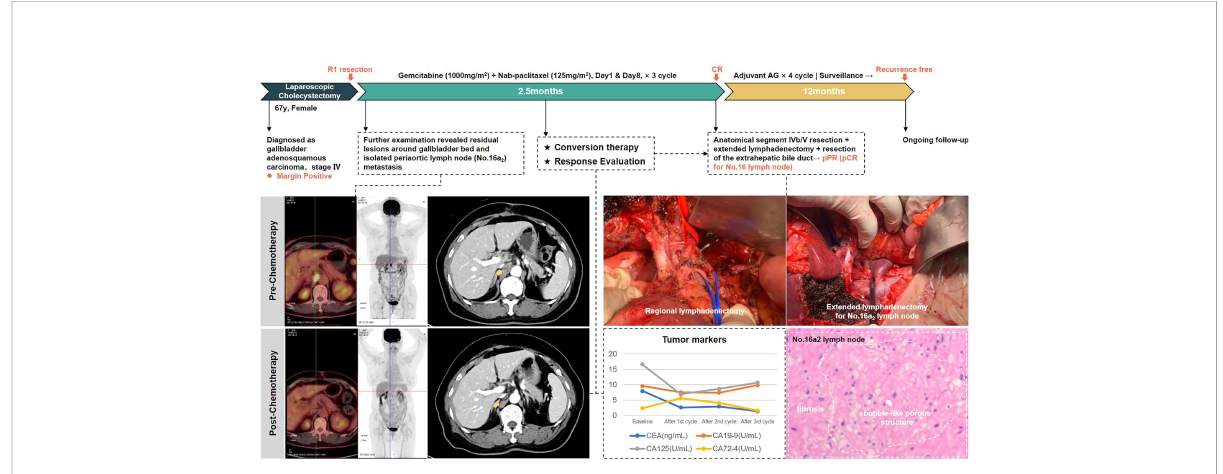
FIGURE 4 The treatment process of patient #2.